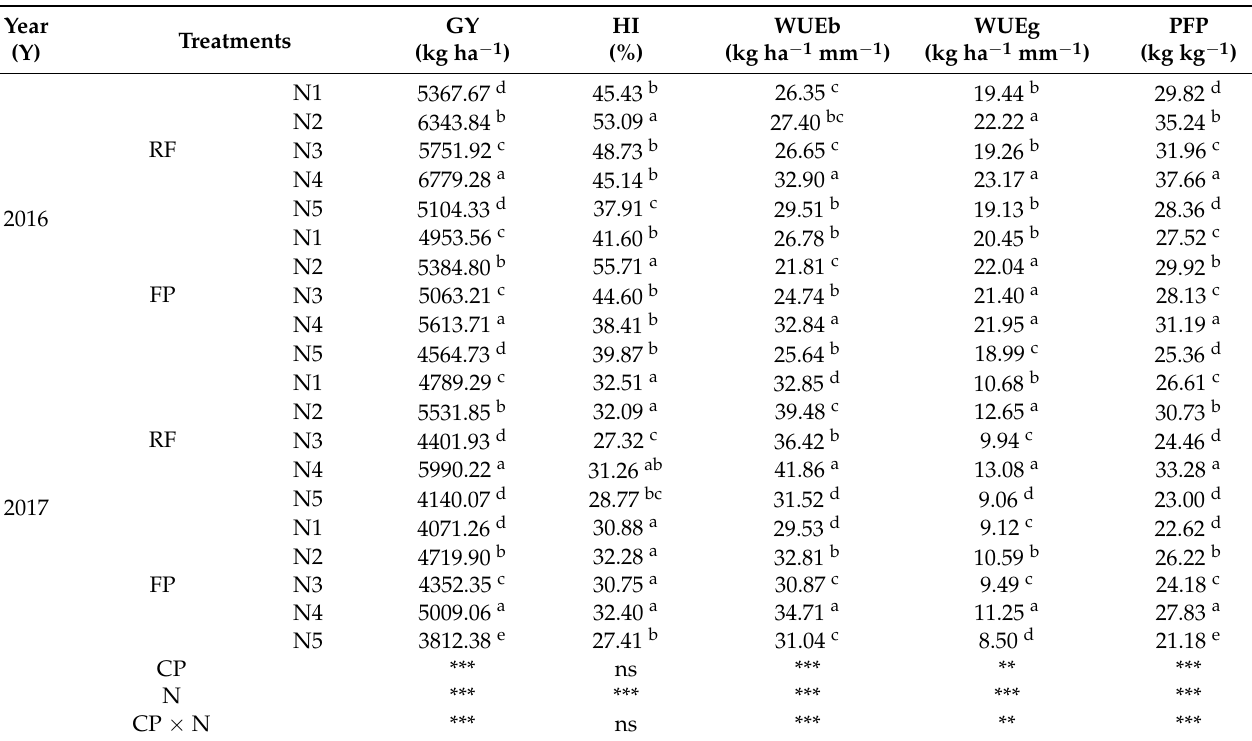
Table 6. Effects of the different treatments on grain yield (GY), harvest index (HI), water use efficiency (WUEb and WUEg), and partial factor productivity (PFP).